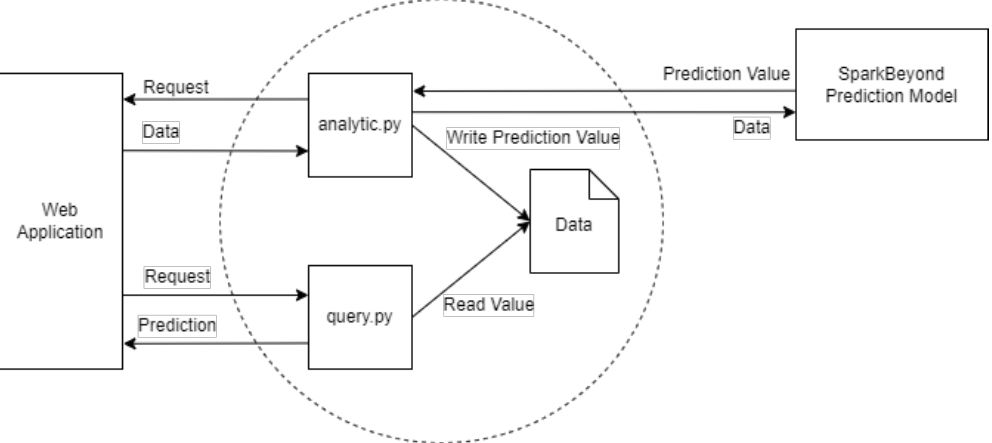
Figure 4. The diagram for processes and components of the prediction API. Sensor data are trained to build a prediction model in the data analytics platform which then returns a suggested dim- ming